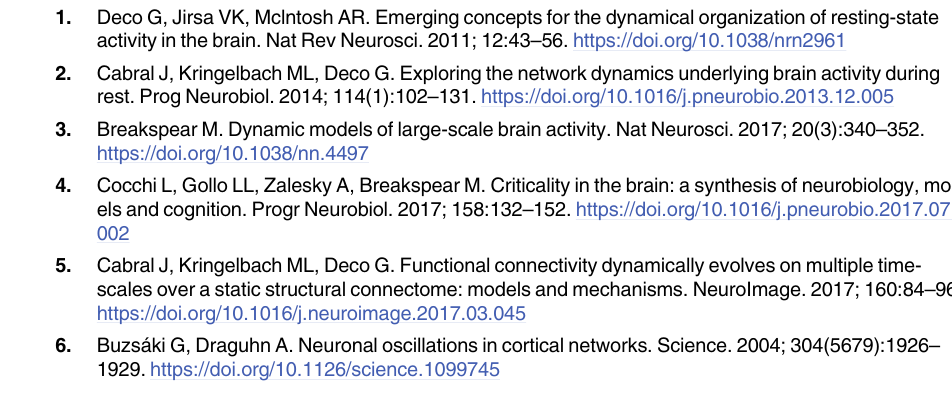
S6 Fig. Trajectories of the modeled delta-alpha PAC dynamics in the condition d = 1. The surrogate data testing did not reject the null hypothesis H eled delta-alpha PAC dynamics. This Figure corresponds to Fig 8A to 8D, and depicts the case of K = 3 for comparison